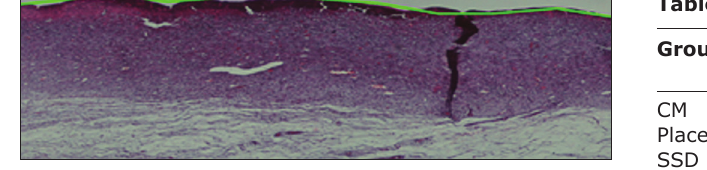
Figure-2: Skin tissue (hematoxylin and eosin staining); damage had reached all the dermis and the tissue below the dermis; there were no hair follicles or oil glands found on the dermis layer.